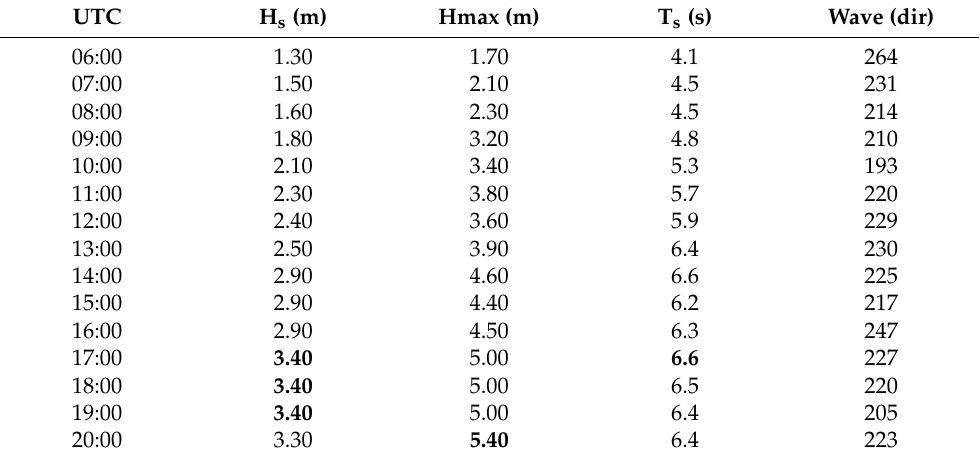
Table 5. Observed waves data of SWB-07 Massalubrense Buoy (courtesy of Parthenope University). Maximum values in bold text. Data are in reference to 28 December